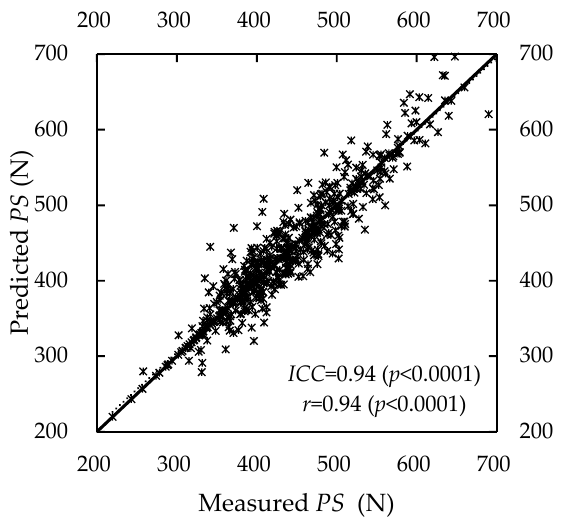
Figure 6. Measured and predicted PS showing PS recovery.